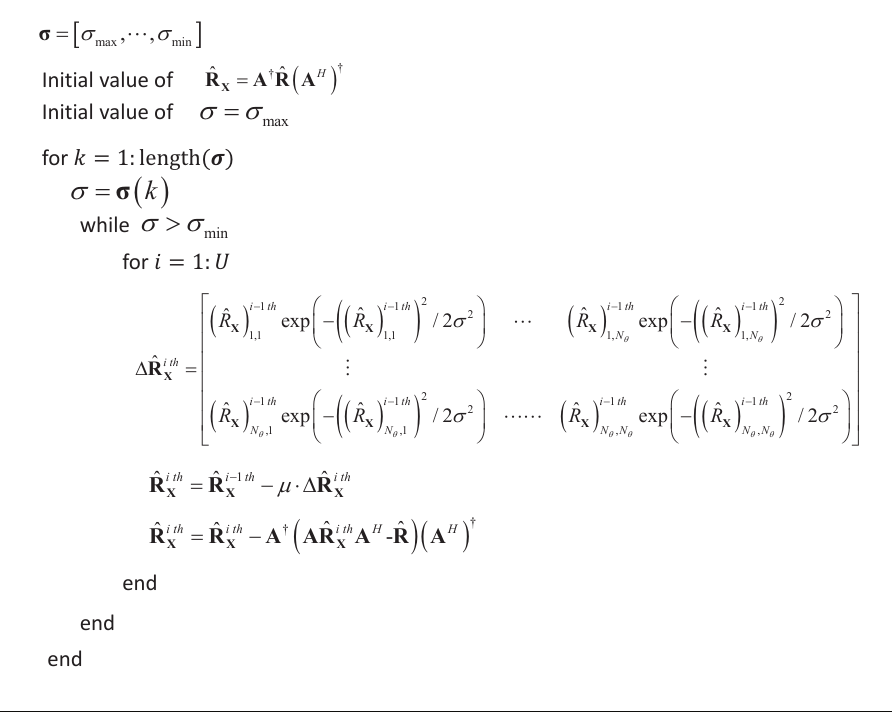
Figure 1. The concept of the covariance-fitting SL0 (correlated